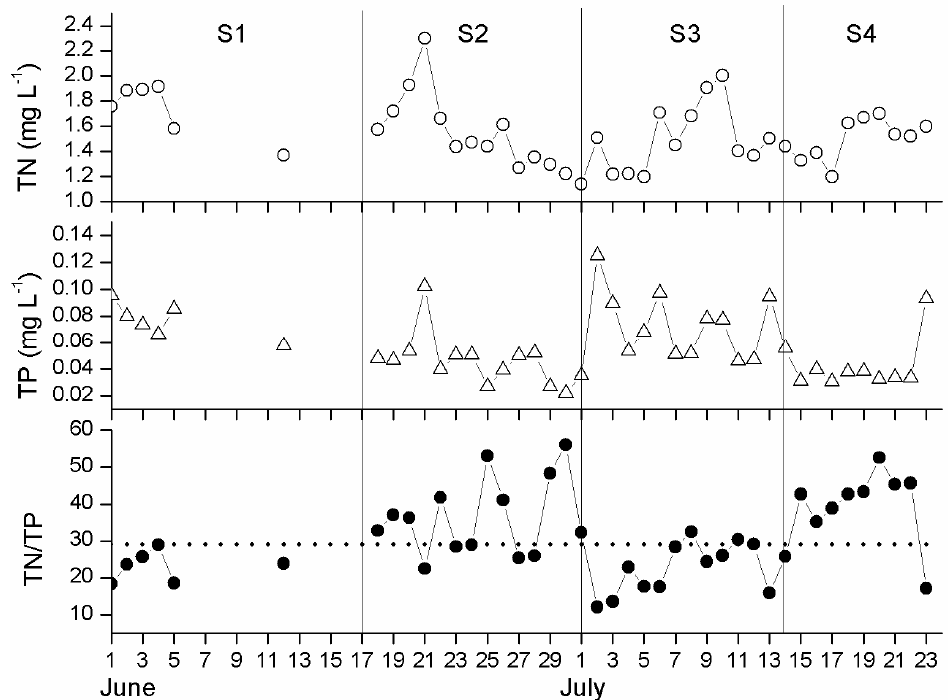
Figure 5. Daily variations of the nutrients in the surface water of Xiangxi Bay from 1 June to 23 July 2008. The dotted line in the figure shown in TN / TP ratio represents TN / TP = 29. S1–S4 were divided according to the value of TN / TP = 29. S1: TN / TP < 29, S2: TN / TP > 29; S3: TN / TP < 29; S4: TN / TP > 29.